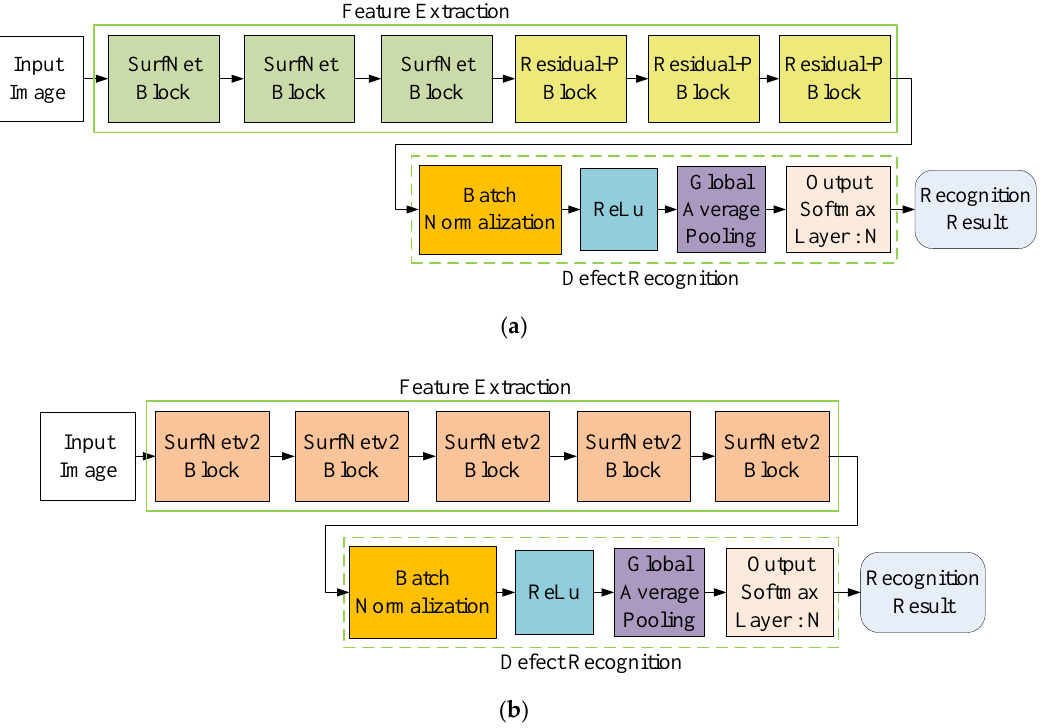
Figure 8. Network architecture of ( a ) the original SurfNet and ( b ) the proposed SurfNetv2 model.